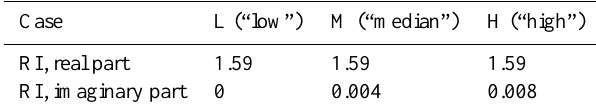
Table 5. Refractive index (RI) values used for case